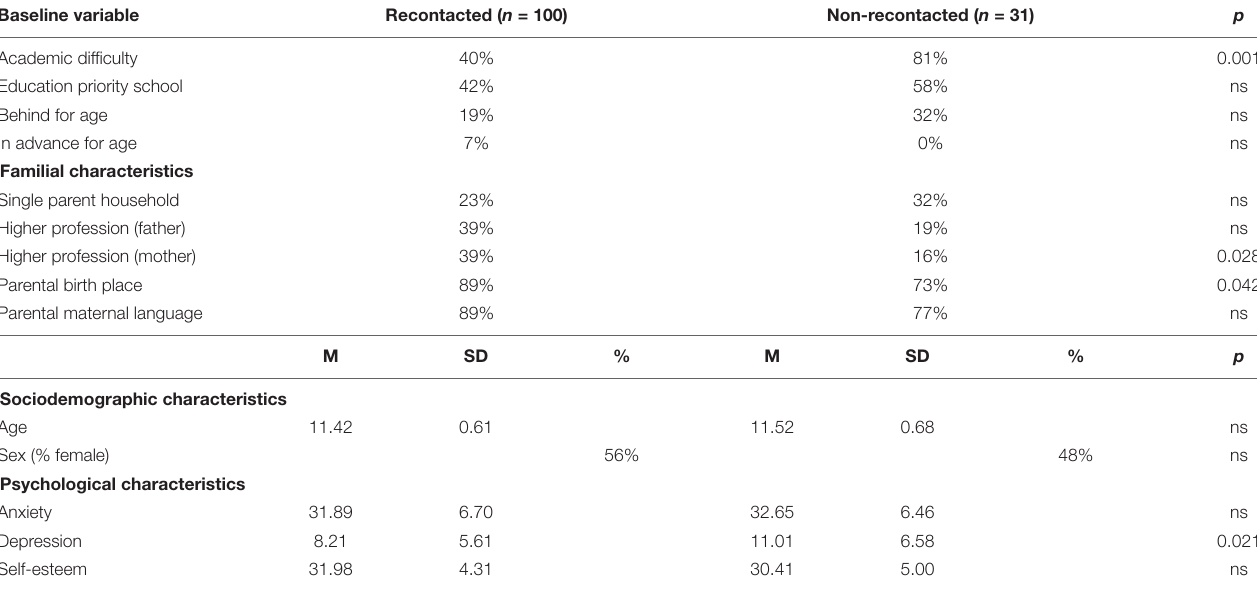
TABLE 1 | Baseline characteristics of participants recontacted and non-recontacted at 10 years.